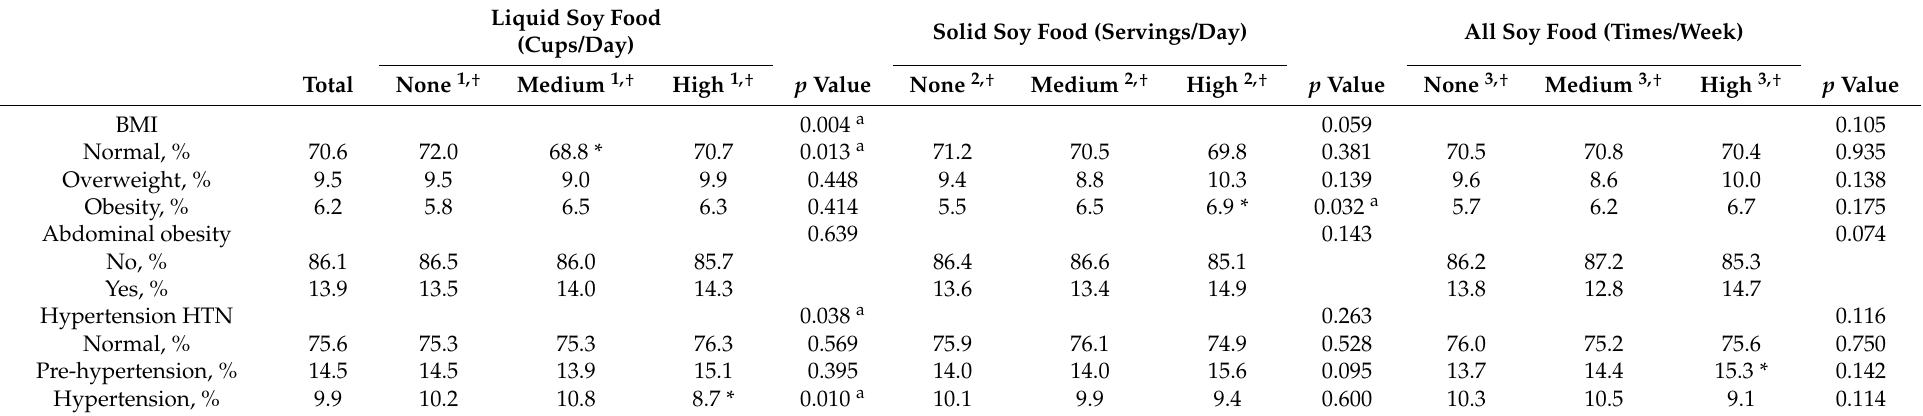
Table 3. The distribution of obesity and blood pressure stratified by soy food intake